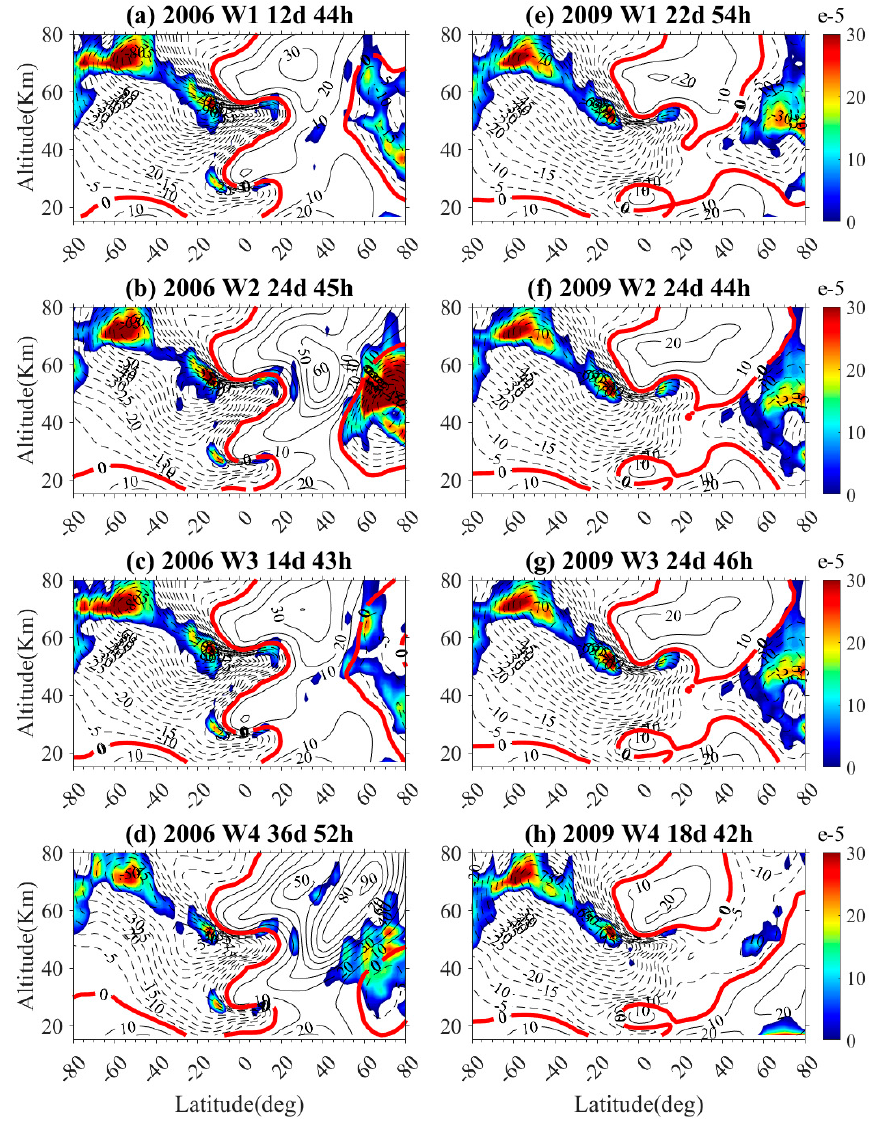
Figure 7. The diagnostic analysis of the W1, W2, W3, and W4 events in 2006 ( a – d ) and 2009 ( e – h ). In the diagnostic analysis, the shaded regions are instability, and the red line is the zero-wind layer. The solid line is the westerly wind and the dotted line is the easterly wind.